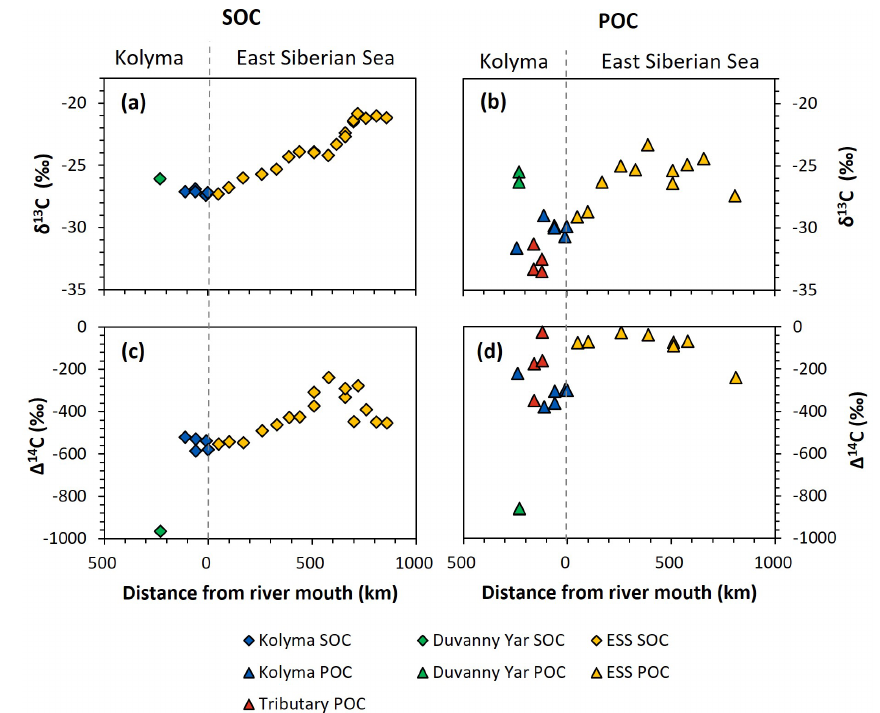
Figure 3. Carbon isotopes over the transect distance, with the riverine part on the left side of each figure, and the marine part on the right. (a) δ 13 C ratio (in ‰ relative to VPDB) of Duvanny Yar (DY; green), Kolyma (blue), and East Siberian Sea (ESS; yellow) sediment organic carbon (SOC). (b) δ 13 C ratio of DY (green), Kolyma (blue), tributaries’ (red), and ESS (yellow) particulate organic carbon (POC). (c) (cid:49) 14 C ratio of DY, Kolyma, and ESS SOC. Lower (cid:49) 14 C ratios indicate older OC. (d) (cid:49) 14 C ratio of DY, Kolyma, tributaries’, and ESS POC.